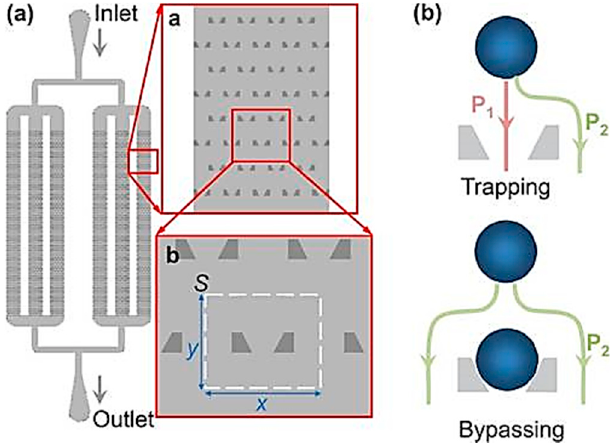
Figure 10. Schematic representation of the microfluidic microsphere-trap array. ( a ) Layout (top view): Microfluidic channels with hydrodynamic trap arrays. The channels are connected by a common inlet and a common outlet. Liquid solution carrying the microspheres flows from the inlet and through the chamber; ( b ) Trapping mechanism. Reproduced from [68] with the permission of AIP Publishing.